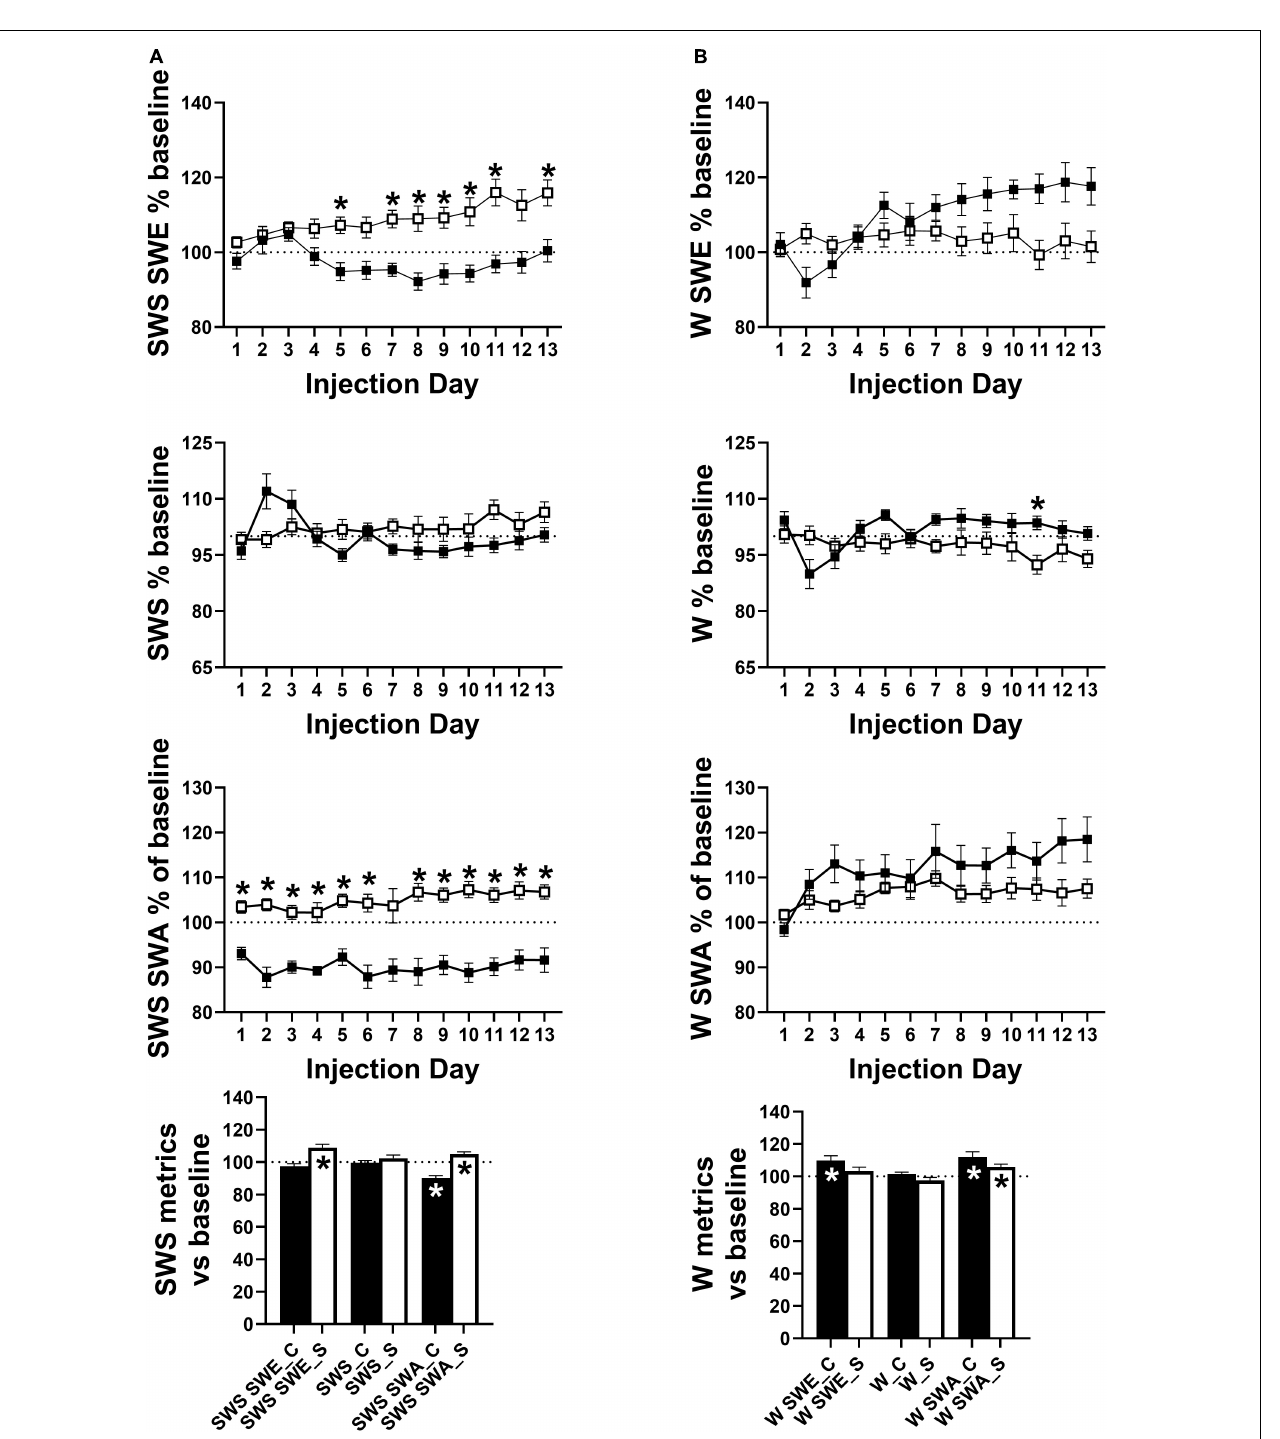
FIGURE 6 | (A) SWS SWE was significantly lower in cocaine-treated animals compared to saline-treated animals driven not by a difference in SWS time but driven by lower SWS SWA. The group difference in SWS SWE and SWS SWA resulted from differences in SWS SWA relative to baseline with decreased and increased average SWS SWA in cocaine-treated and saline-treated animals, respectively. (B) W SWE, W time, and W SWA did not differ significantly by group, however, W time was non-significantly higher in cocaine-treated animals while all metrics showed an effect of time and interaction between group and time with W SWE and W SWA diverging by group as the 13 days period progressed. While both groups showed increased average W SWA relative to baseline, average W SWE was only increased above baseline in cocaine-treated animals. Cocaine n = 10, saline n = 9. Dashed lines at 100 indicates baseline level, asterisks above symbols indicate group difference at those timepoints, asterisks within bars indicate a within-group difference from baseline. P and F values are given in Table 1 and statistics for all pairwise comparisons with significant difference or trends toward significance are given in Supplementary Table 4 .